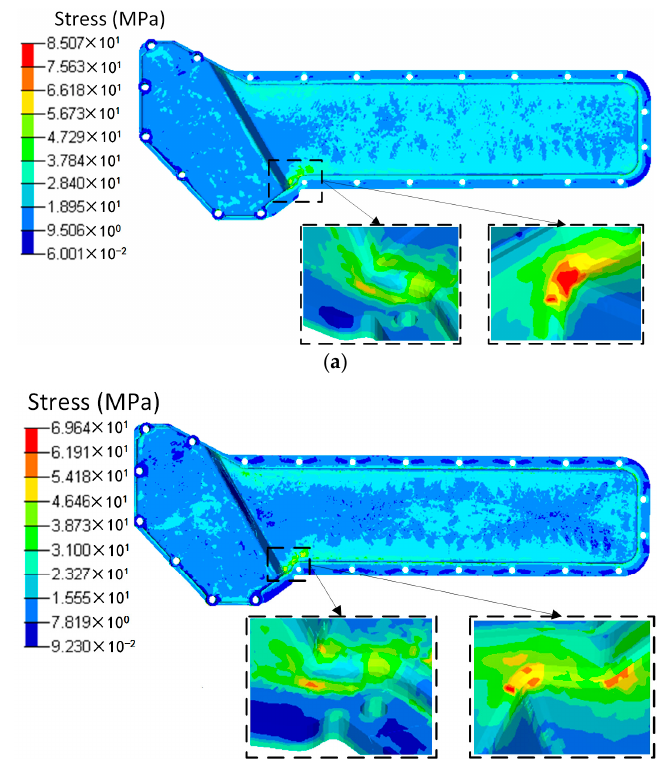
Figure 18. Stress distributions of ( a ) the isotropic and ( b ) the orthotropic oil cooler covers under distributed pressure and temperature difference.